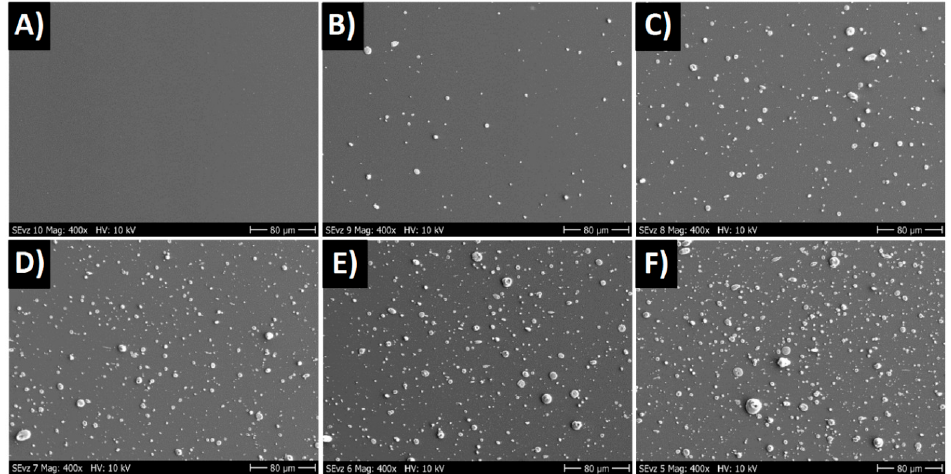
Figure 2. SEM images of Ge-doped DLC layers, 400× magnification. ( A ) 0 at.%, ( B ) 1 at.%, ( C ) 2.5 at.%, ( D ) 5 at.%, ( E ) 9 at.%, and ( F ) 12 at.% of Ge in DLC.